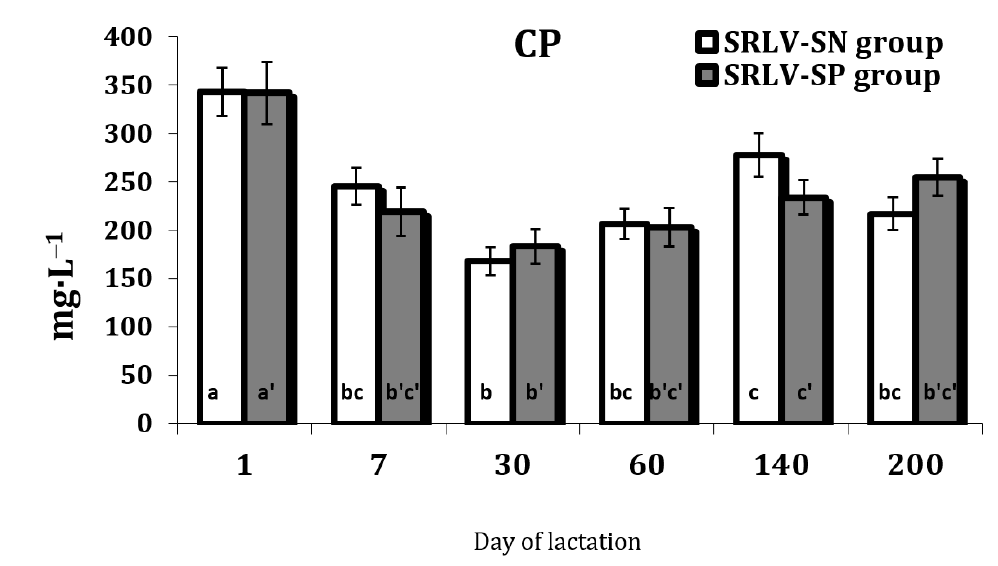
Figure 5. Ceruloplasmin level (Cp, mg · L − 1 ) in the serum of SRLV-SN and SRLV-SP goats during lactation. Values are expressed as means ± SEM; a, b, c—different letters indicate significant differences between stages of lactation within the SRLV-SN group at p < 0.05; a’, b’, c’—different letters indicate significant differences between stages of lactation within the SRLV-SP group at p < 0.05; SRLV-SP—small ruminant lentivirus seropositive goats; SRLV-SN—small ruminant lentivirus seronegative goats.